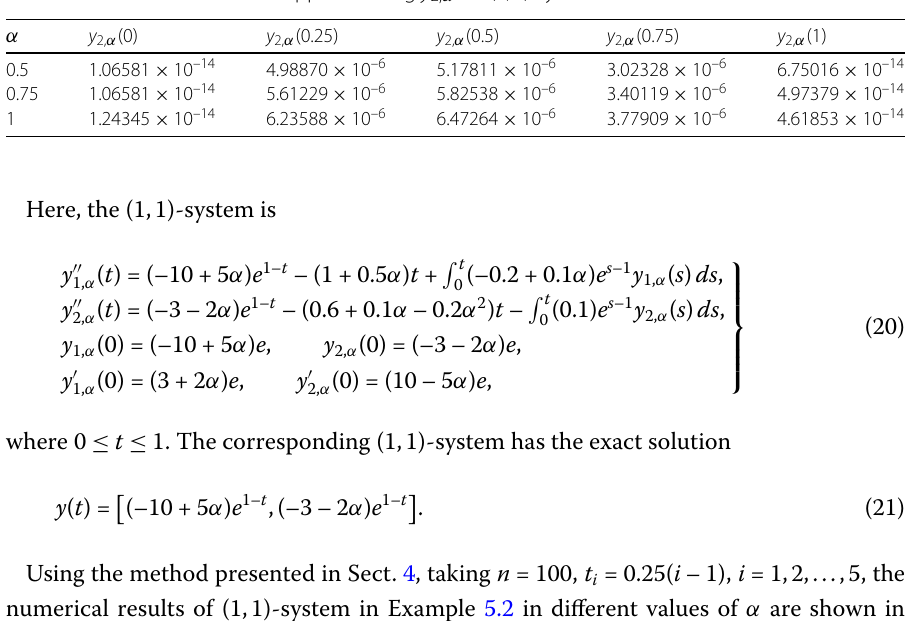
Table 8 The absolute errors of approximating y 2, α for (1,1)-system at various t and